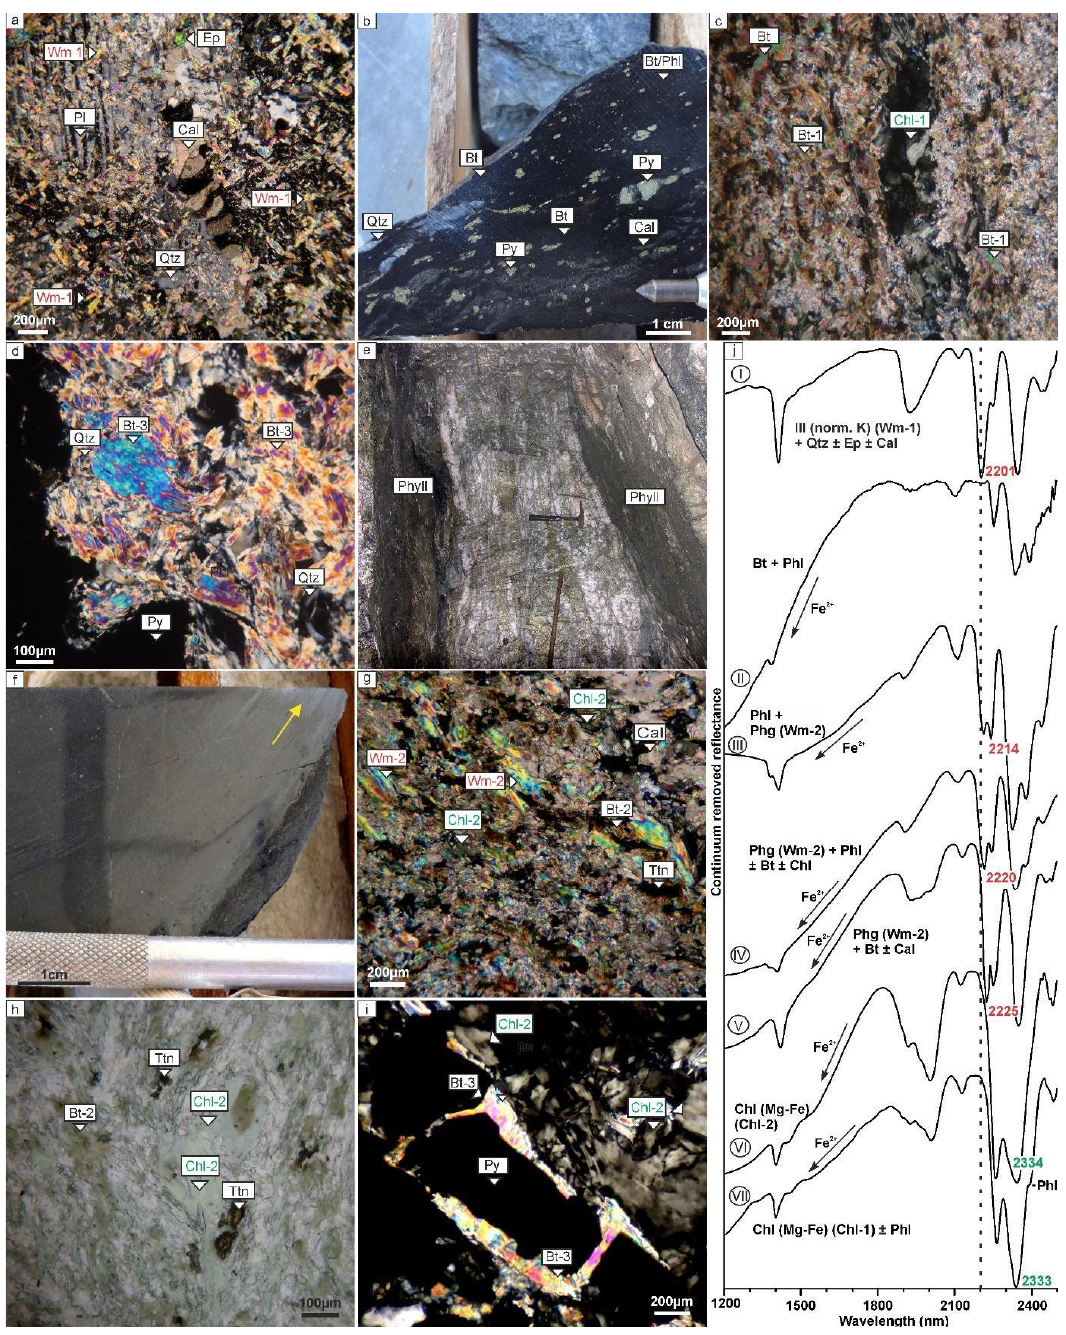
Figure 5. Group 1 hydrothermal alteration zones. ( a , c , d , g , i ) Cross-polarized and ( h ) plain-polarized thin section microphotographs, ( b , f ) hand samples, ( e ) underground mine, and ( j ) reflectance spectra. ( a ) Illitic zone in the Paraíba tonalite, Wm – 1 defines de S n+1 phyllonitic foliation. Plagioclase alteration generates fine grain white mica (Wm – 1). Calcite veinlets and epidote from propylitic alteration crosscut Wm – 1 (sample BH020-001 in Figure 4). ( b ) Biotite zone constitutes the biotite-phlogopite phyllonite. The pyrite aggregates, micas, and quartz or calcite bands defined the phyllonite foliation (sample BH020-019). ( c ) In the biotite zone, biotite (Bt – 1) and chlorite (Chl – 1) lenses define the phyllonite foliation (sample BH059-041). ( d ) Biotite zone composed of stretched phlogopite lamellae (Bt – 3) with irregular grain boundaries. Note the mica fish microstructure (sample BH041-016). ( e ) Main Paraíba gold-quartz vein. Laminated quartz and sulfide bands define the foliation and are parallel to the vein walls. Phyllonite (Phyll) hosts the veins. ( f ) Greyish black, fine-grain